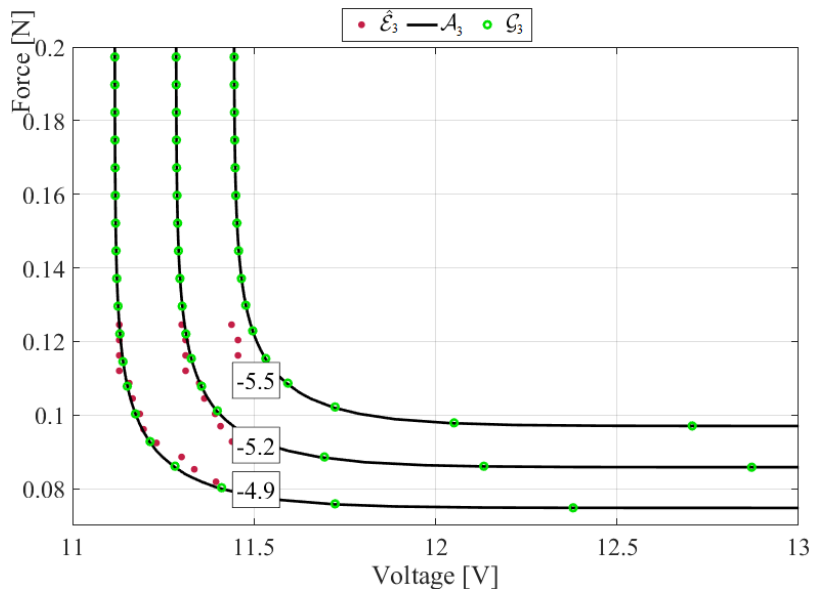
Figure 5. Optimised Asymmetric logistic 𝓐 𝟑 (𝝃,𝜼) ( — ) contour plot and (A) empirically estimated 𝓔̂ ˆ E ( ξ , η ) ( • ), (B) optimised Gumbel logistic G 𝟑 (𝝃,𝜼) ( • ), (B) optimised Gumbel logistic 𝓖 𝟑 (𝝃, 𝜼) ( ∘ ). Negative numbers reflect probability levels 3 on a decimal logarithmic scale. on a decimal logarithmic